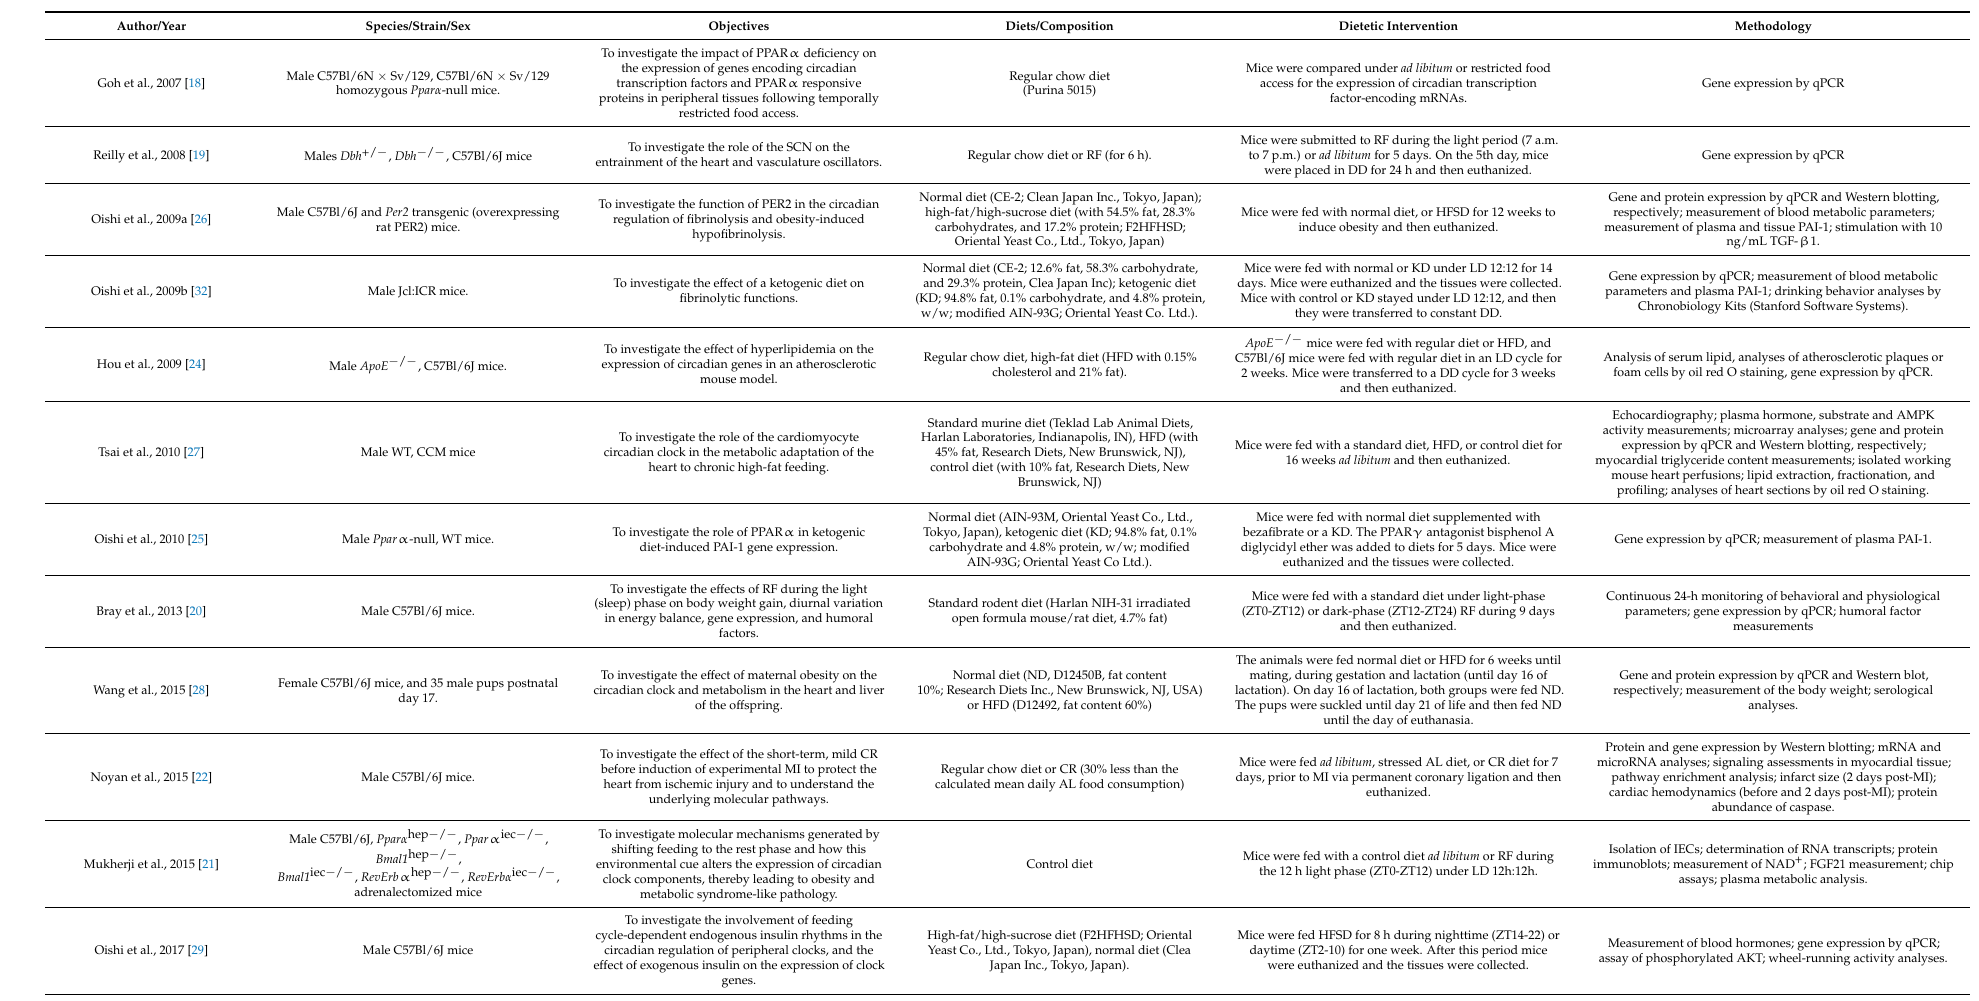
Table 2. Objectives and methodologies used in the